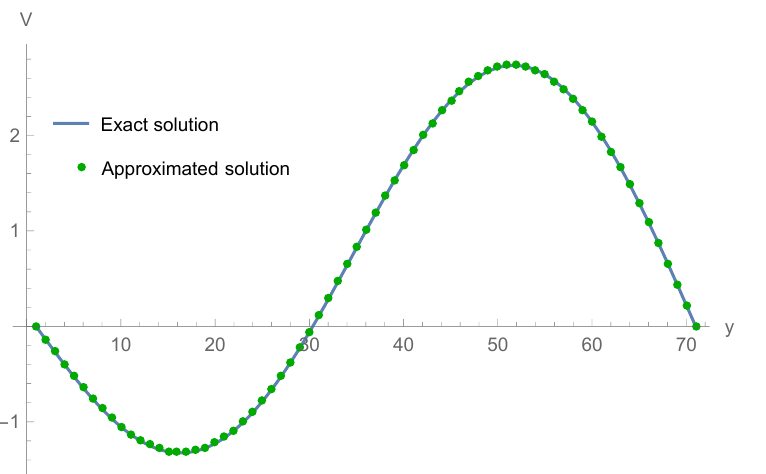
Figure 6 . Comparison of the exact and the computed values of Example 2 at γ = 0.5 and α =